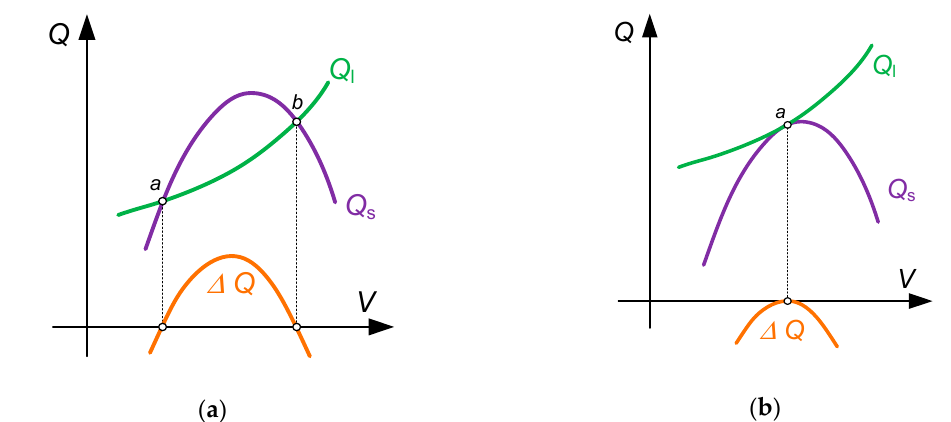
Figure 3. Illustration of the mutual location of the production and reception characteristics: ( a ) two points of equilibrium; ( b ) one point of equilibrium.